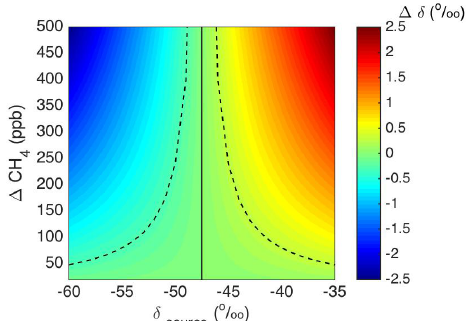
Figure 1. Isotopic ratio difference from background ( (cid:49)δ) resulting from a mixture of background and source signatures, as a function of source isotopic ratio ( δ source ) and CH 4 mole fraction enhance- ment above background ( (cid:49) CH 4 ) . Here the source end-members are − 60 and − 35‰. Background CH 4 mole fraction was assumed to be 2000ppb, and background isotopic ratio − 47.5‰ (vertical solid line). Dashed lines indicate − 0.3 and 0.3‰ difference from back-